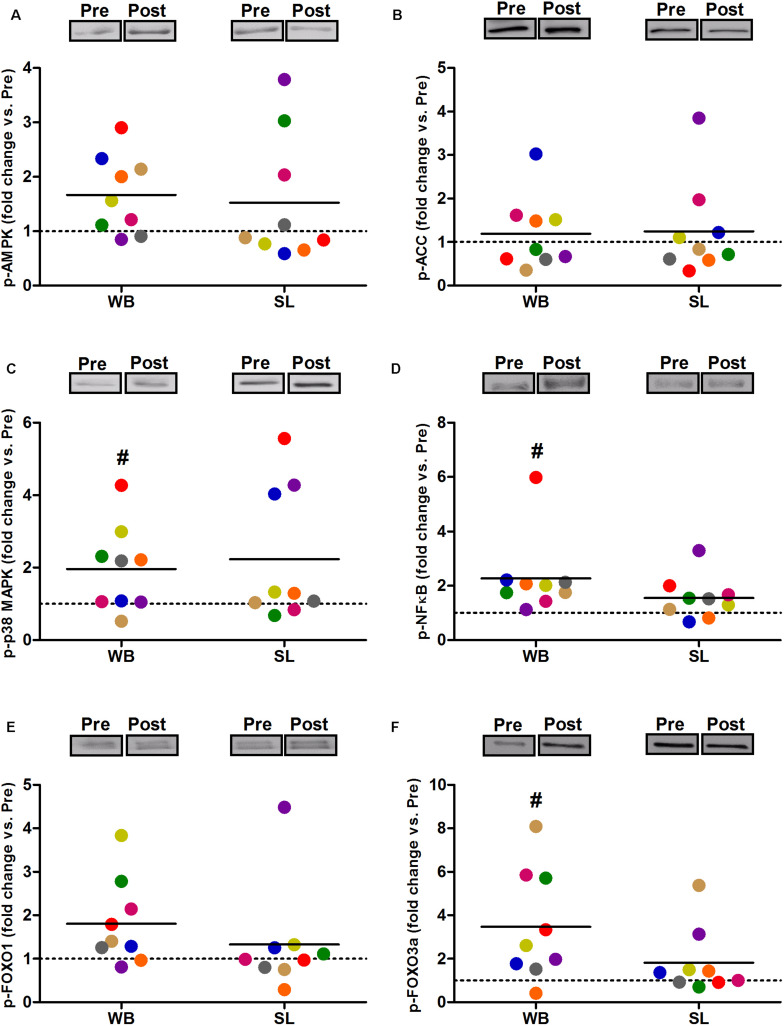
Changes in the phosphorylated state of AMPK Thr172
(A), ACC Ser79
(B) p38 Thr180/Tyr182
(C), NFκB Ser536
(D), FOXO1 Thr24
(E), and FOXO3a Thr32
(F) during whole body (WB) or single-leg (SL) heat stress. #Different compared with PRE within WB.